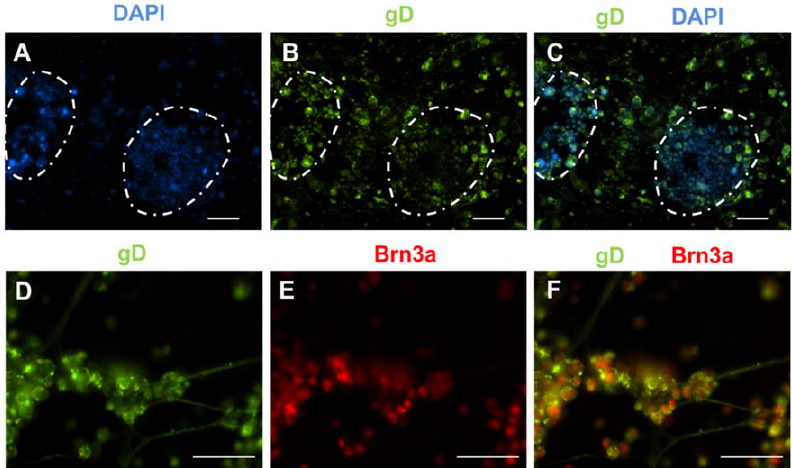
Figure 6. HSV infects iPS cells at all stages of differentiation. Cells were infected with cell-free HSV at a MOI of 0.1 for 96 hours. (A) DAPI staining identifies the iPS cell colonies (highlighted by the dotted white lines). (B) Immunostaining for gD revealed that both iPS cells and the underlying fibroblasts supported HSV infection, as evidenced by abundant gD expression. (C) Merge of panels A and B. (D–F) Sensory neurons derived from iPS cells also supported HSV infection. Staining for gD (D) and Brn3a (E). (F) Merge of panels D and E. Scale for all images is 100 um.